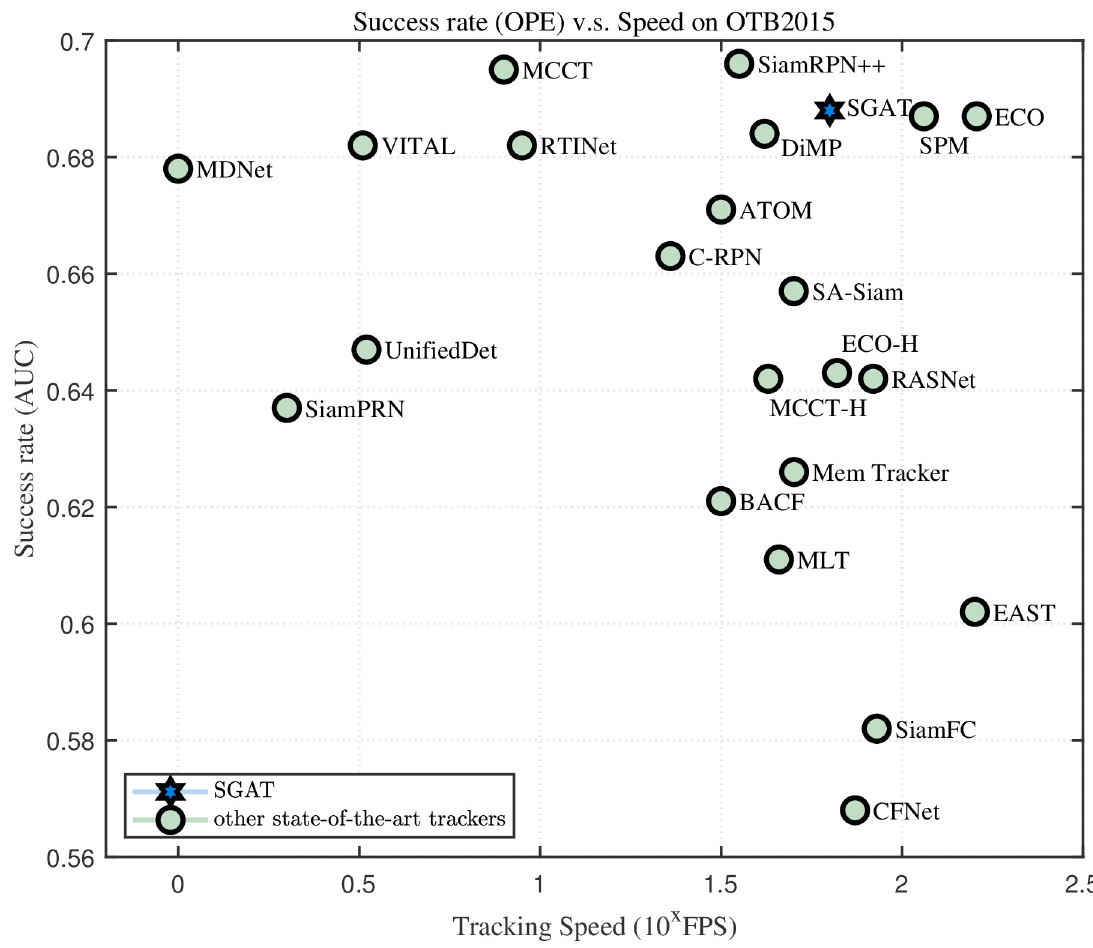
Fig 4. Success rate vs. tracking speed on OTB-100. Here, the x-axis represents the 10th power of the tracking speed and the y-axis represents the success